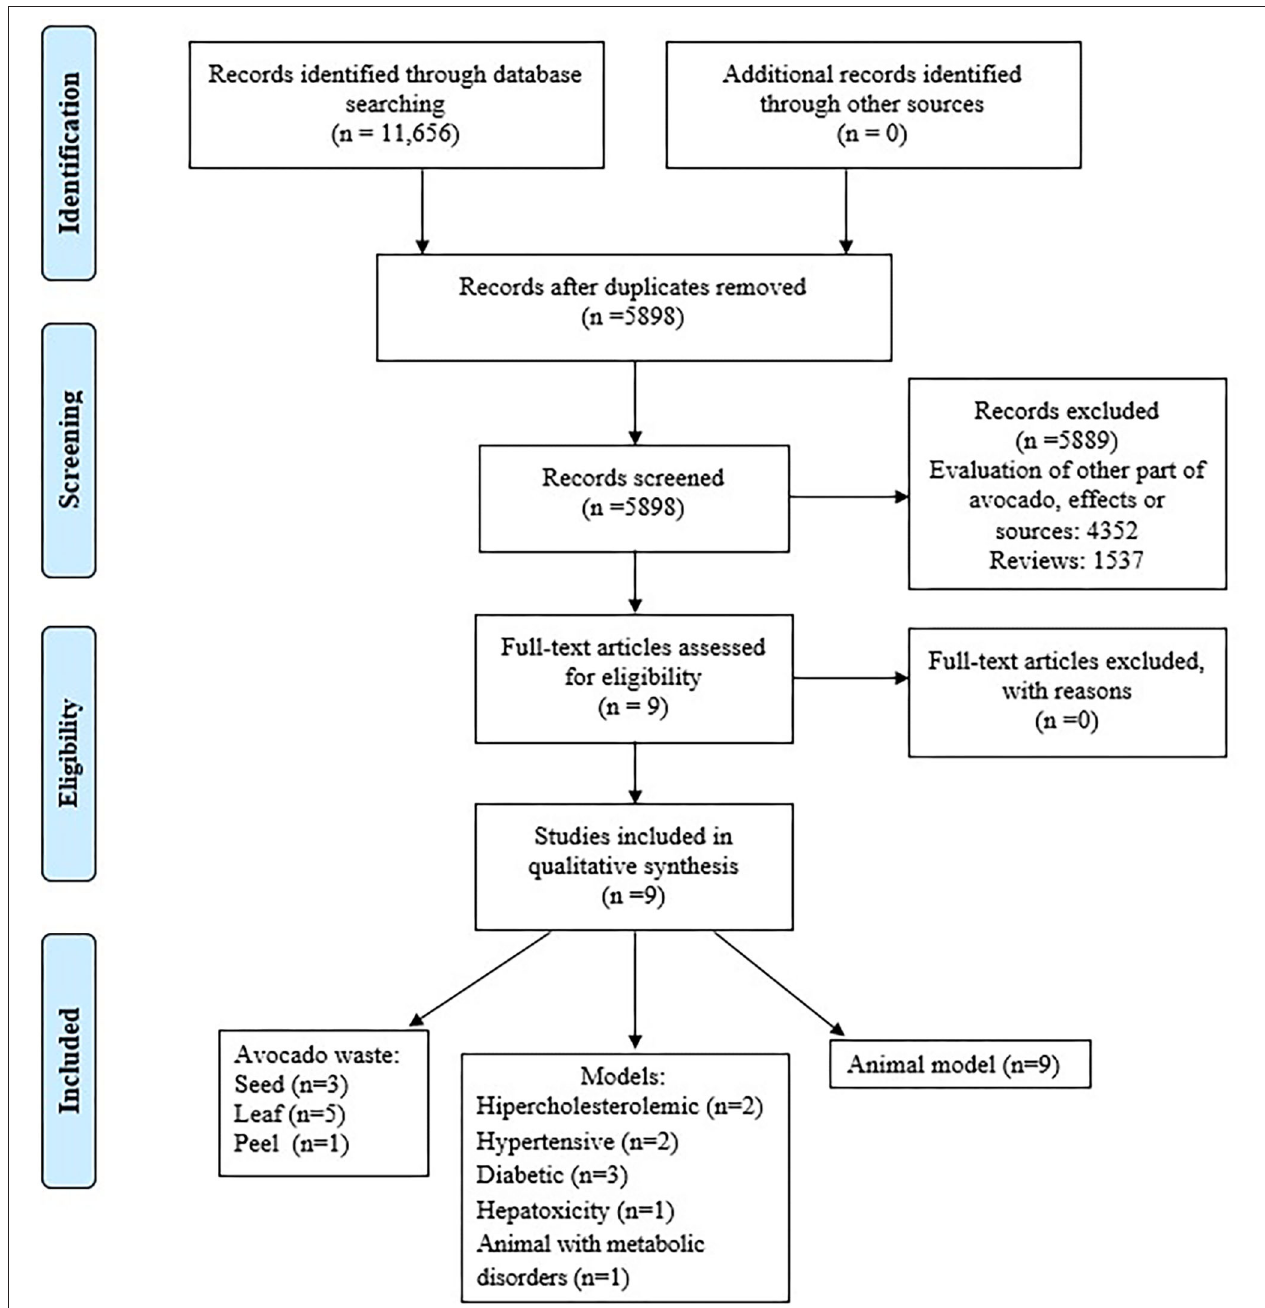
FIGURE 1 | Flowchart of the election process of the articles included. Adapted from Moher et al.